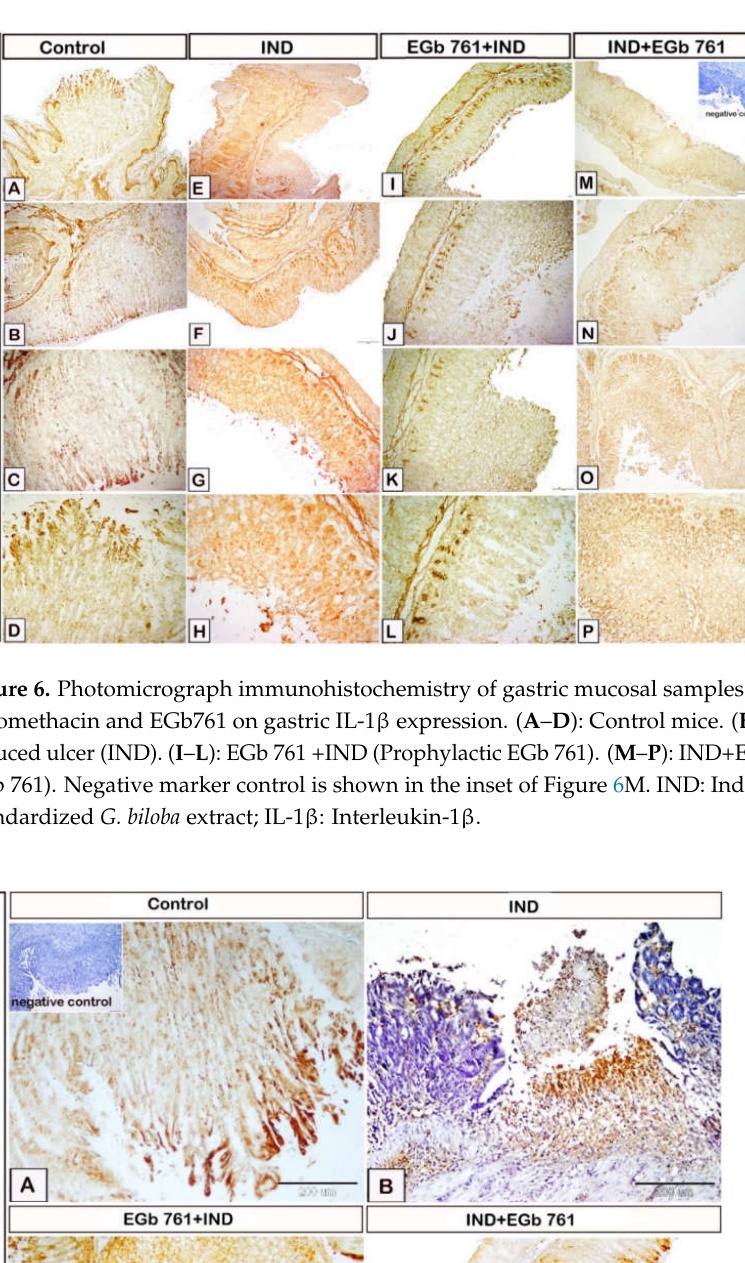
Figure 5. Photomicrograph immunohistochemistry of gastric mucosal expression of COX-2. ( A – D ): Control mice. ( E – H ): Indomethacin-induced ulcer (IND). (I-L): EGb 761 +IND (Prophylactic EGb